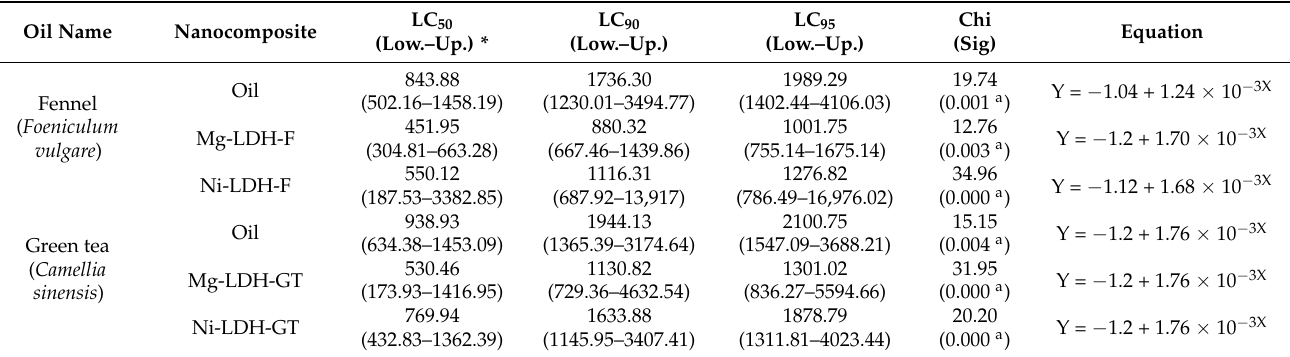
Table 4. The larvicidal effects of fennel, green tea oils and its LDH formulations against Culex pipiens , 24 h post treatments.